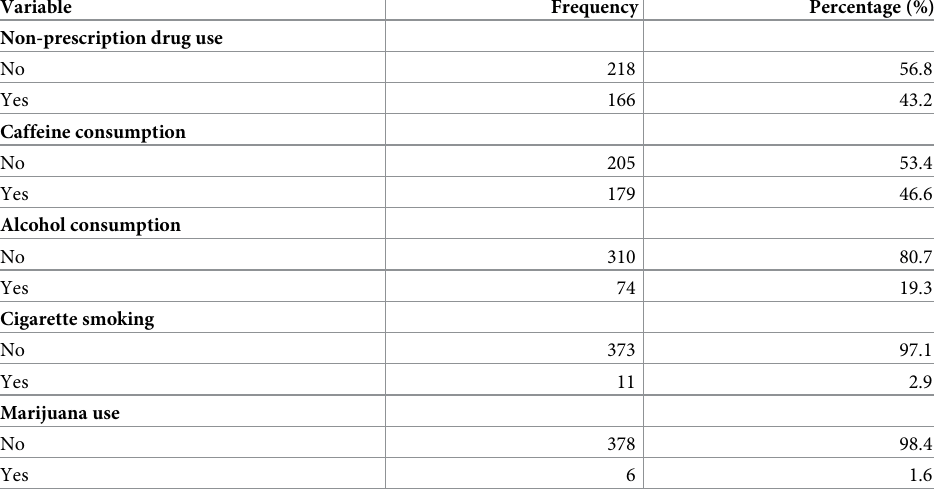
Table 3. Substance use among waiters in upscale